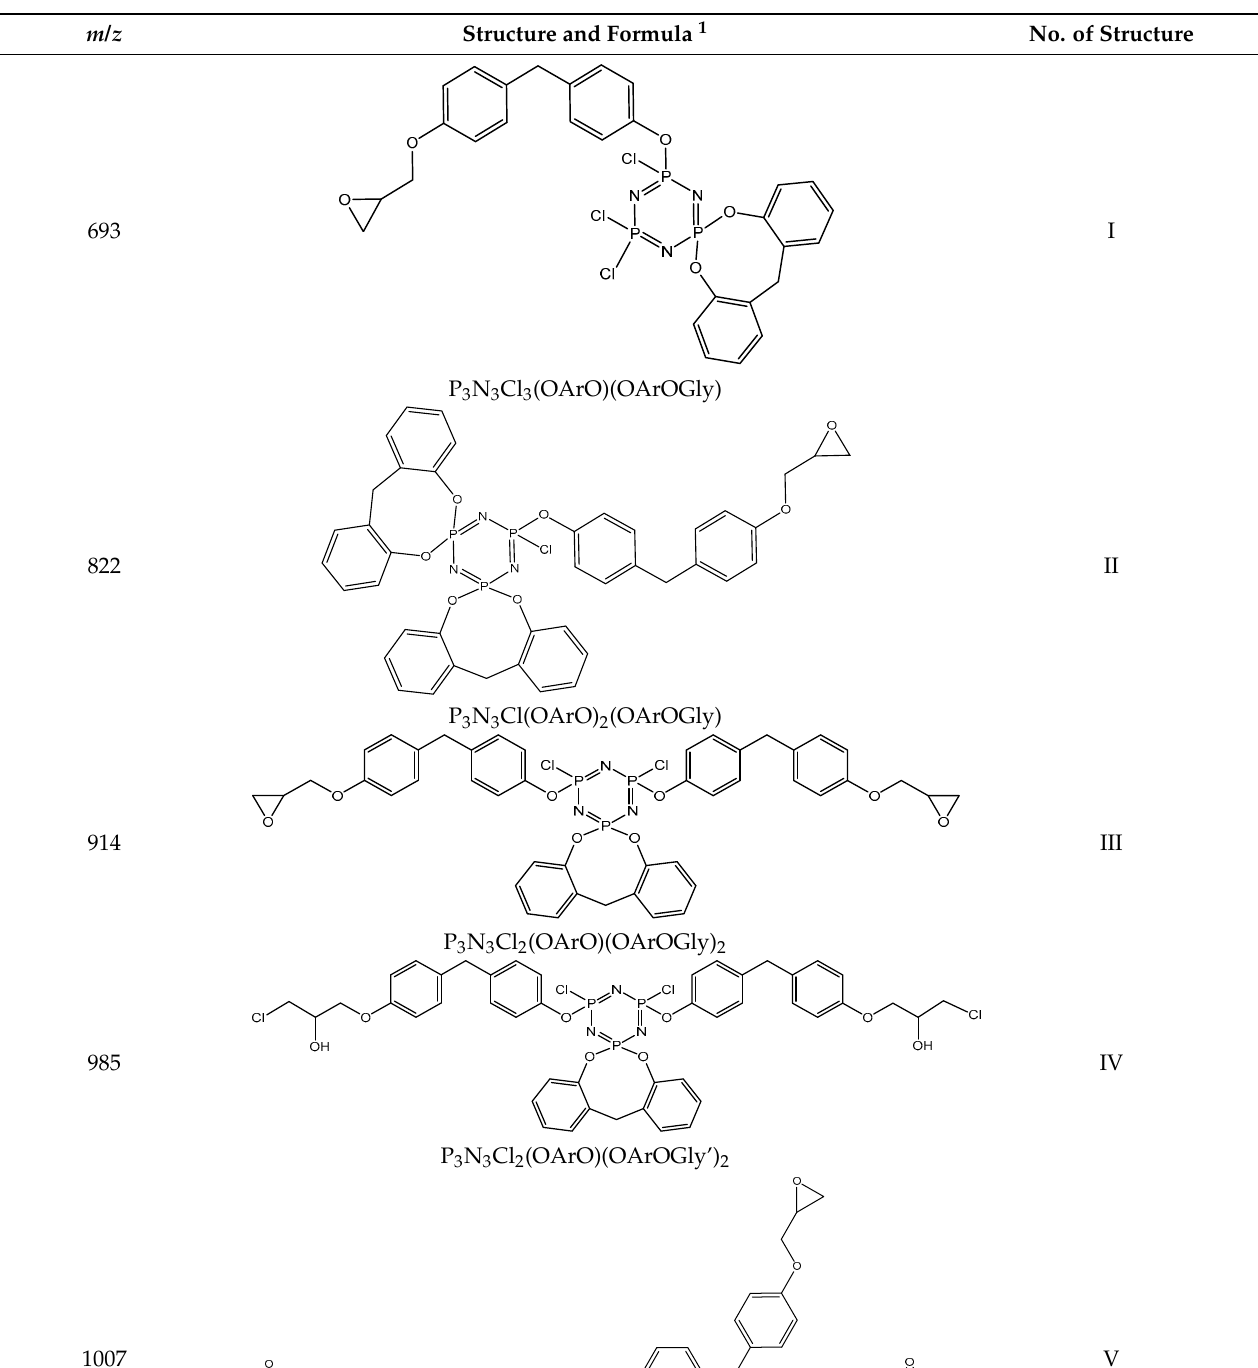
Table 2. Possible structures and formulas of the main compounds formed during the synthesis of PNA-BPF and PNA-BPF-S.